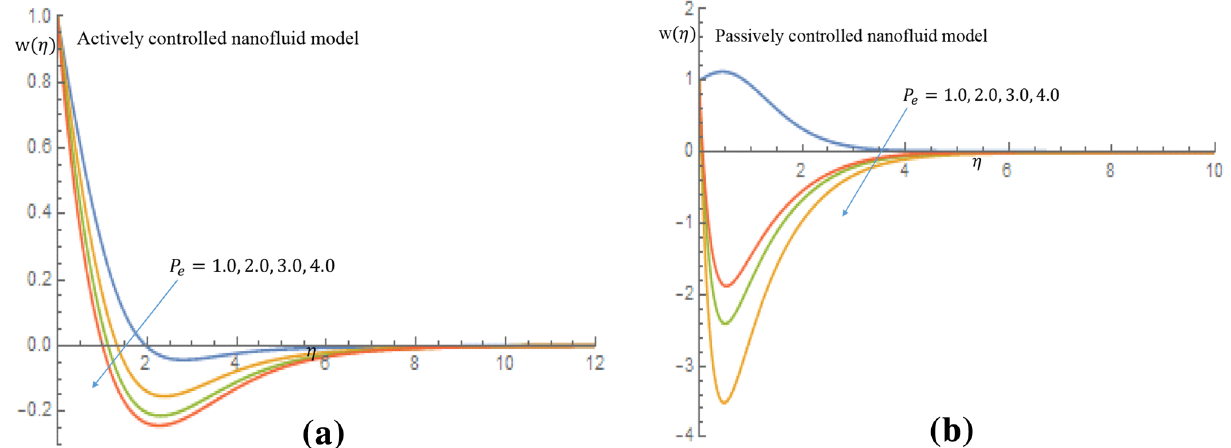
Figure 18. ( a ) Effect of P e on density of motile microorganisms profile when L e = 2.0 . ( b ) Effect of P e on density of motile microorganisms profile when L e = 2.0